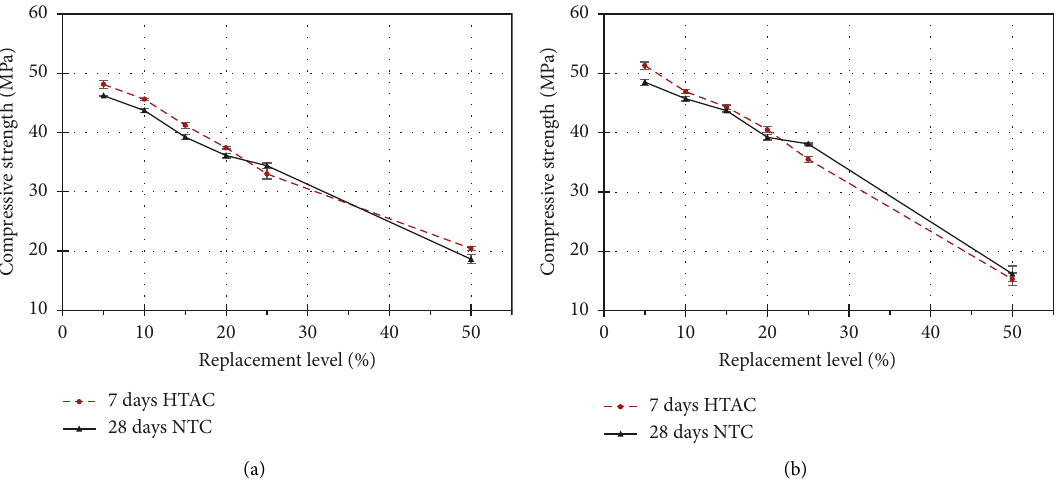
Figure 13: Strength comparison between 7 days HTAC mortars and 28 days NTC mortars. (a) Raw LFS-blended mortars; (b) Sieved LFS- blended mortars.